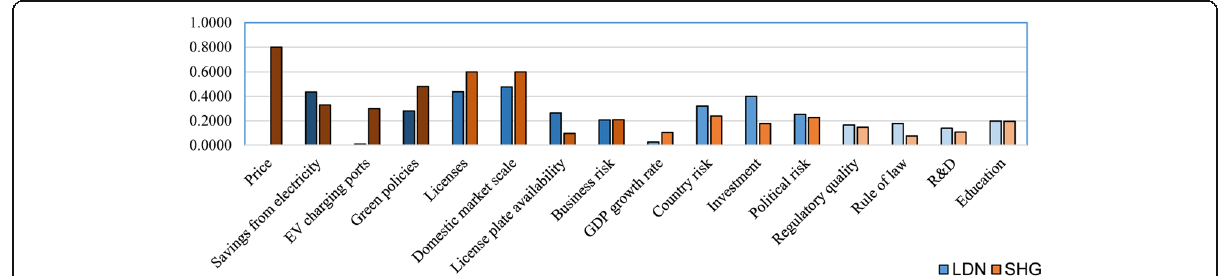
Fig. 3 Results 2.1 subcategories (author ’ s